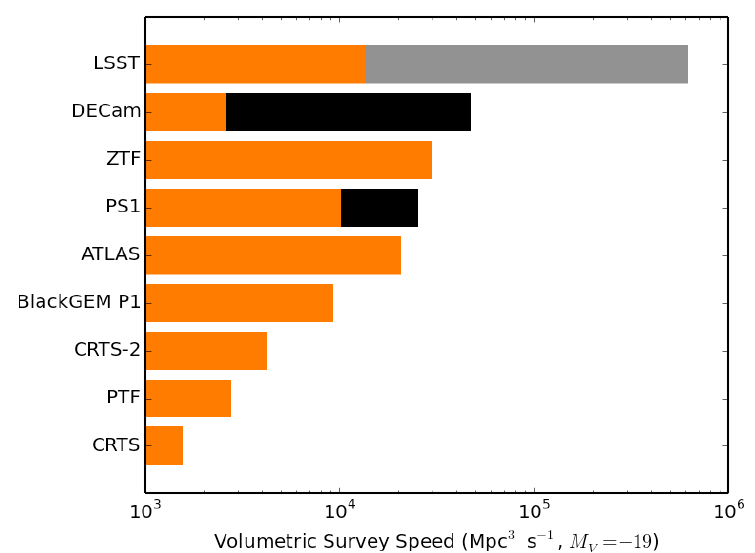
8 Figure 4. Comparison of volumetric survey speeds adopted from https://www.oir.caltech.edu/